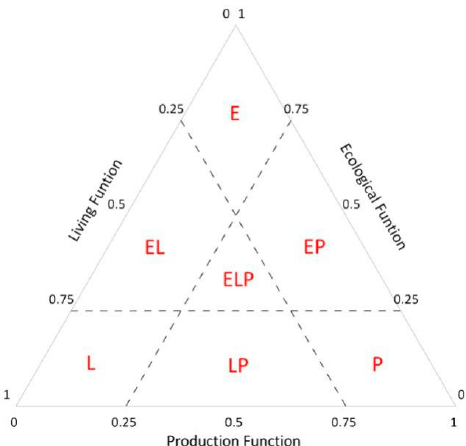
Figure 2. The seven types of production-living-ecology land use functions combinations in the triangle model.